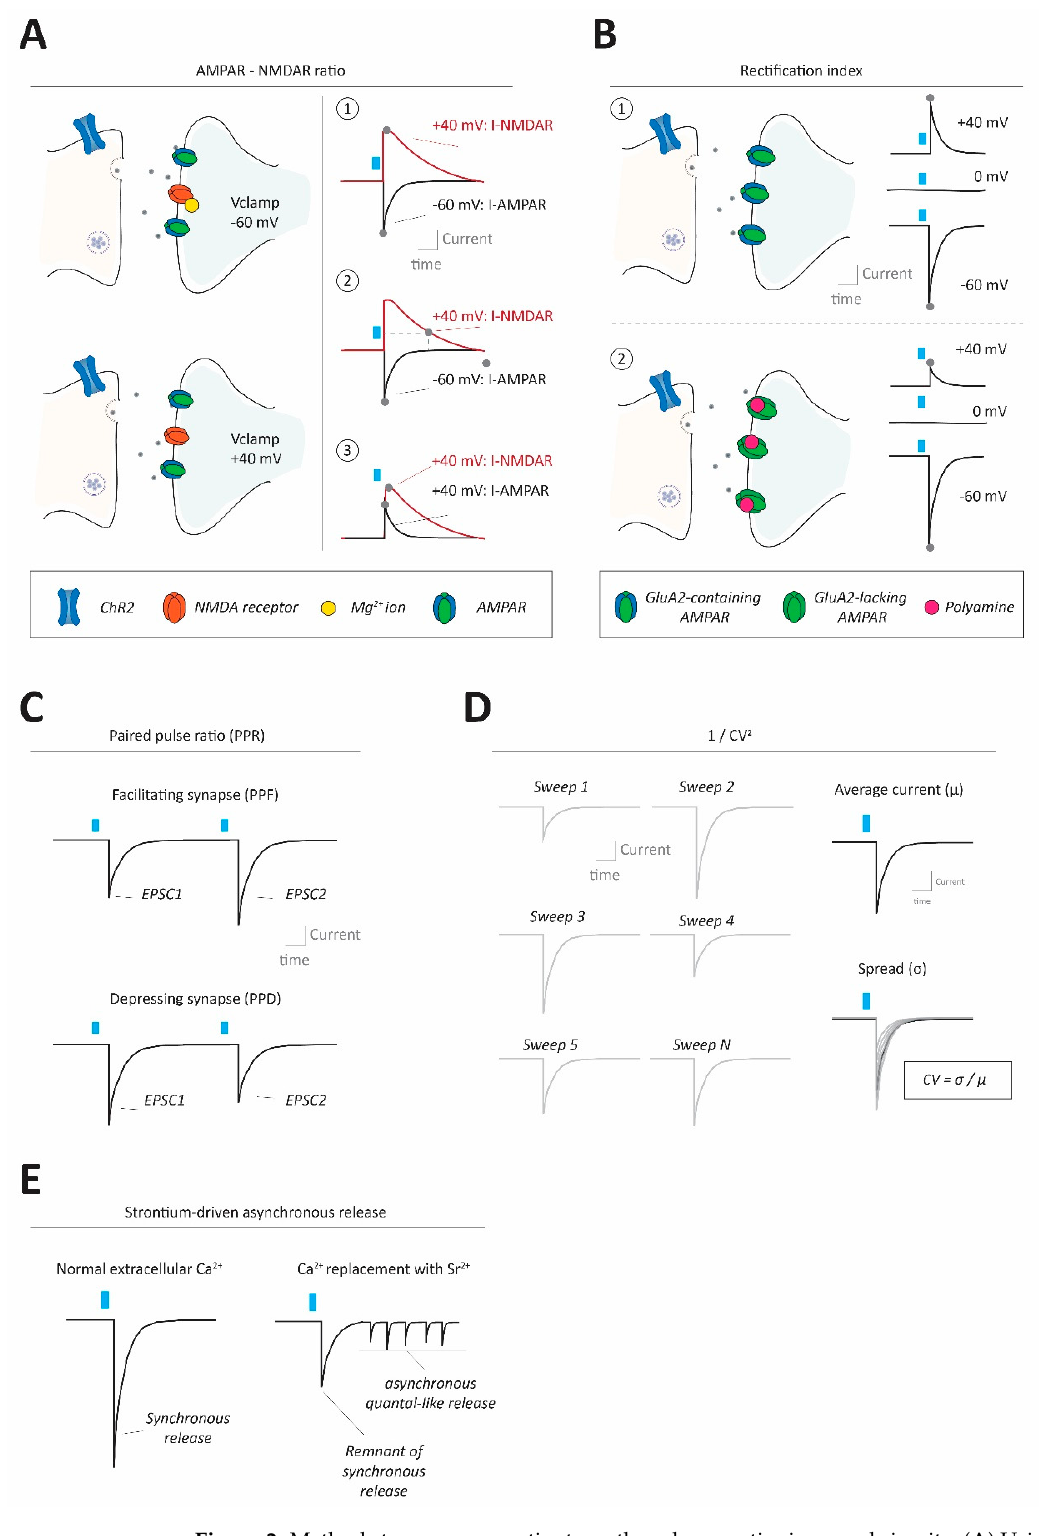
Figure 2. Methods to assess synaptic strength and properties in neural circuits. ( A ) Using optogenetic stimulation at excitatory synapses AMPA-NMDA ratios can be calculated to gauge synaptic strength, by normalizing AMPAR-mediated to NMDAR-mediated currents (I-AMPAR; I-NMDAR). This can be done in different ways, requiring conditions to separate the two currents from each other. A 1 : Clamping the cell at − 60 mV allows for determination of I-AMPAR at peak values (without I-NMDAR contributions due to its block by Mg 2+ ions under these conditions, top left), and then clamping